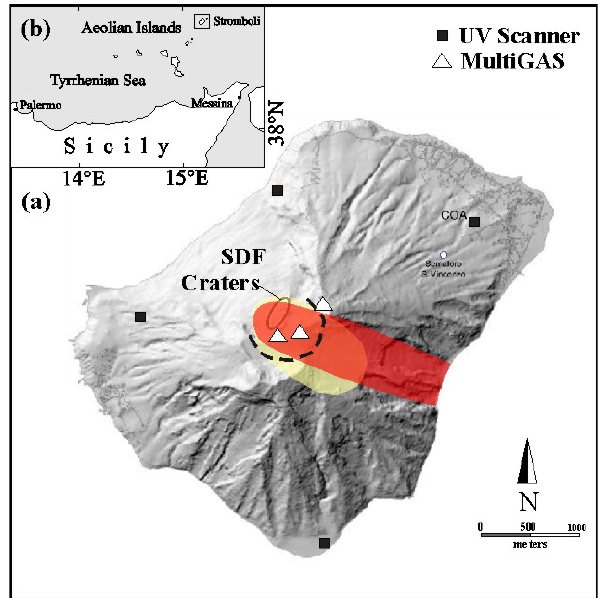
Fig. 1. (a) Map of Stromboli with locations of MultiGAS and UV scanner stations; the typical dispersal area of fallout deposits of Stromboli’s major explosion is given by the 24 November 2009 major explosion example (modified from Andronico and Pistolesi, 2010): red area: pumice fallout; yellow area: spatter and bombs; back dashed line, limit of the area affected by ballistic lithic fallout; (b) Position of Stromboli relative to